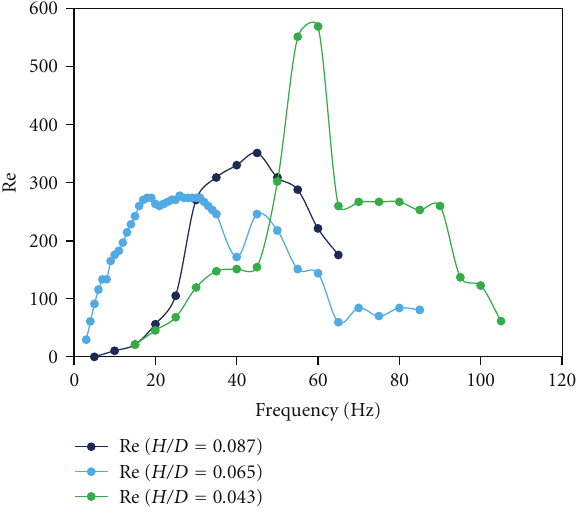
Figure 10: The Reynolds number of ethanol flow under di ff erent H/D